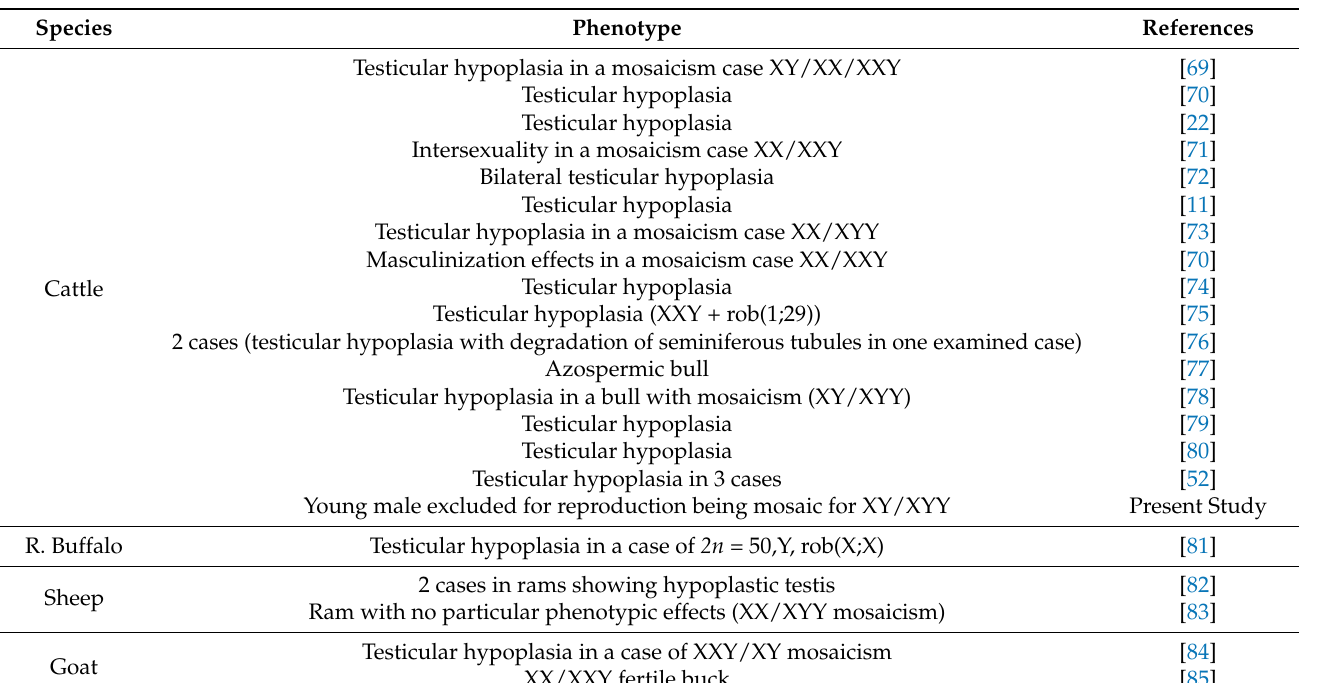
Table 5. XXY-syndrome in domestic bovids.